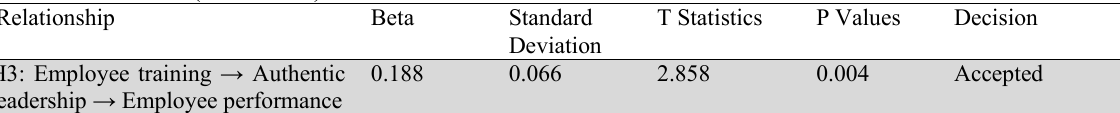
Results of indirect